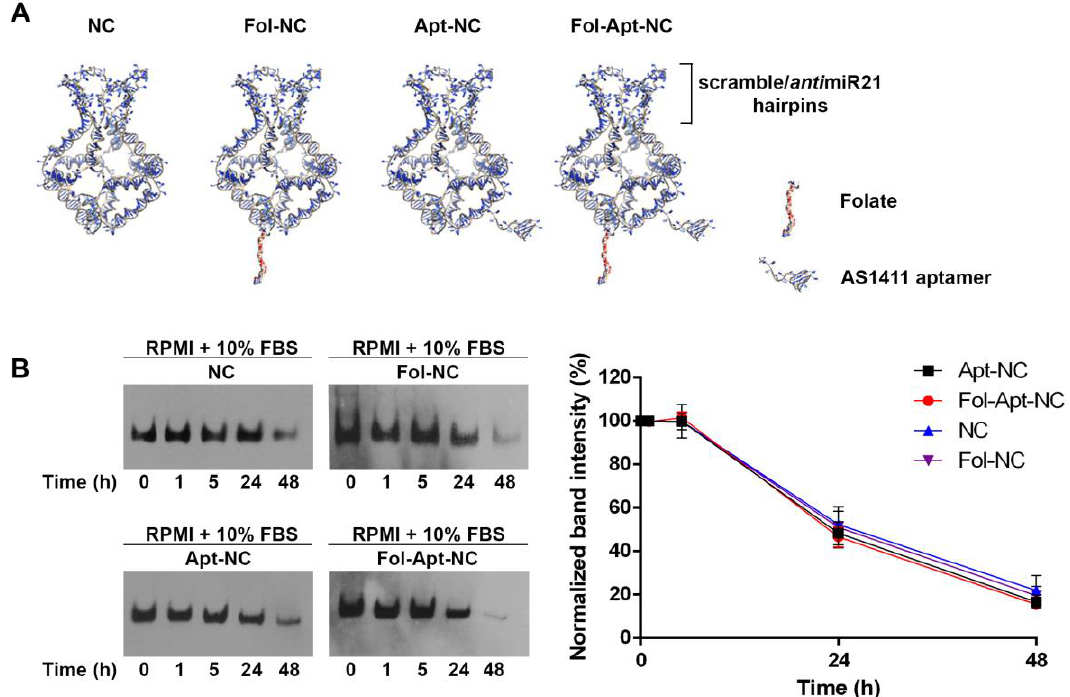
Figure 1. ( A ) Schematic representation of octahedral nanocages (NC), folate-functionalized nanocages (Fol-NC), AS1411-linked nanocages (Apt-NC), and both folate and AS1411 functionalized nanocages (Fol-Apt-NC), harboring the scramble or anti-miR21 hairpins. ( B ) DNA blot analysis. Biotinylated nanocages are detected using Streptavidin – HRP. 30 ng of nanocages before incubation with serum proteins (time 0) are shown in each panel. The densitometric analysis (shown in the right panel) was performed using ImageJ software. The relative intensity of each band was normalized to the intensity of the band corresponding to each time 0 and reported in the graph. The graph shows average ± SEM of three different experiments.